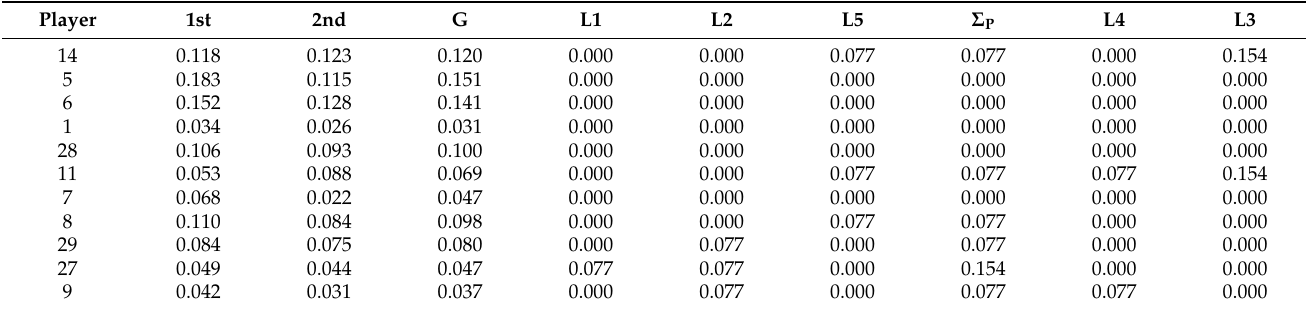
Table A8. Team B’s Degree Prestige Matrix of